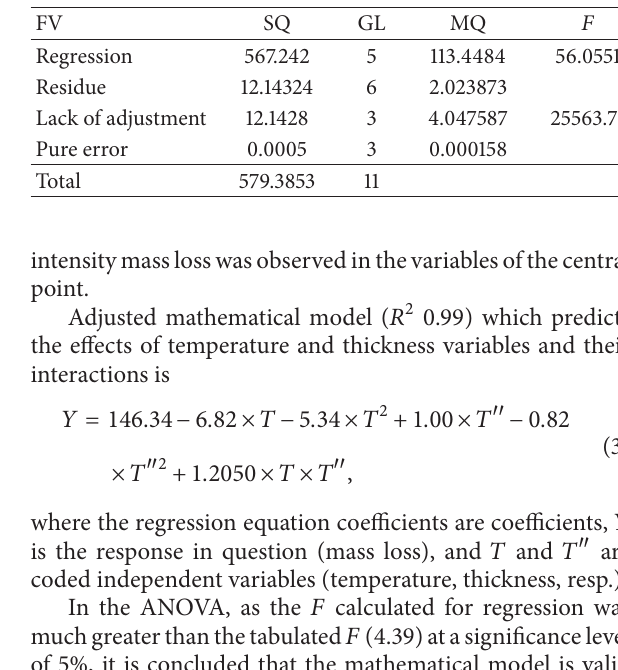
Table 6: Analysis of variance (ANOVA) for tomato mass loss subjected to different thickness and temperatures during